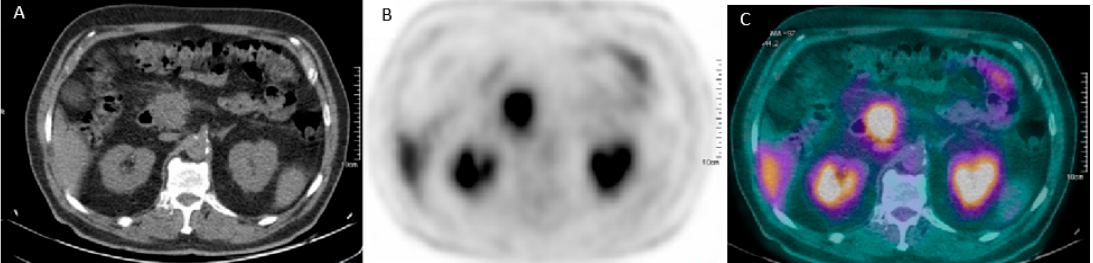
Figure 1. Transaxial low-dose co-registered CT ( A ), PET ( B ) and fused PET / CT ( C ) images show increased 18 F-FDG uptake in the pancreatic tumoural lesion ( C ).